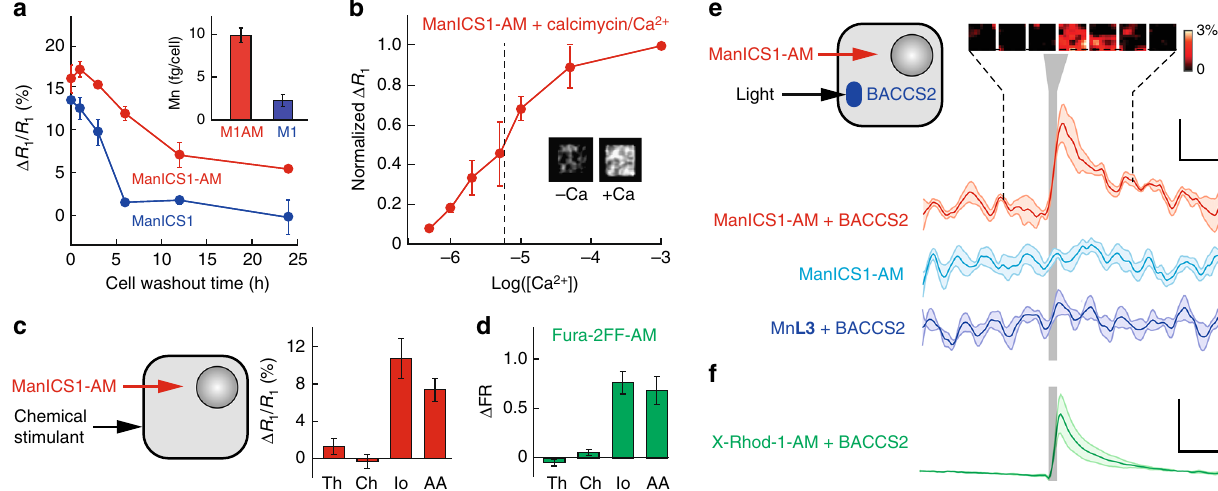
Fig. 4 ManICS1 reports calcium-dependent MRI signal changes in cells. a Washout time course of Δ R 1 / R 1 vs. time for HEK293 cells preincubated with 10 µ M ManICS1-AM (red) or ManICS1 acid form (blue). Elemental analysis of cytosolic fractions from incubated cell lysates (inset) indicates intracellular manganese accumulation in ManICS1-AM (M1AM)-treated cells but not ManICS1 (M1)-treated cells. b Titration of extracellular calcium concentration equilibrated in the presence of 10 µ M of the Ca 2 + ionophore calcimycin in ManICS1-AM-loaded cells. A midpoint of calcium-induced changes occurs at [Ca 2 + ] = 5 µ M. Inset compares MRI scans of cell pellets imaged in the absence (left) vs. presence (right) of 1 mM calcium. c Calcium responses measured from HEK293 cells labeled with ManICS1-AM and treated by extracellular addition of chemical stimulants (left). Signi fi cant R 1 changes are observed in response to ionomycin (Io) and arachidonic acid (AA) ( p ≤ 0.001), but not thapsigargin (Th) or carbachol (Ch) ( p ≥ 0.2). d Responses measured by fl uorescence spectroscopy from cells loaded with the fl uorescent calcium indicator Fura-2FF-AM under stimulation conditions as in c . e Cells were loaded by incubation with 40 µ M ManICS1-AM, transfected with the light sensitive Orai calcium channel activator BACCS2, and stimulated with 480 nm light (diagram at left). The red time course shows resulting changes in T 1 -weighted signal as a function of time, before, during, and after stimulation (vertical gray bar). Inset at top depicts image snapshots binned over successive 240 s windows during the time series portion indicated by dashed lines and indicating percent signal changes observed at a voxel level. Stimulus-dependent signal changes were not observed in analogous experiments performed using cells lacking BACCS2 (cyan) or cells labeled with Mn L3 instead of ManICS1-AM (blue). f Fluorescence time course observed from BACCS2- expressing cells incubated with 5 µ M X-Rhod-1-AM and stimulated as in panel e . Scale bars: horizontal = 300 s, vertical in e = 0.3%, f = 20%. Error bars represent SEMs of a three, b three, c six, and d six independent measurements. Shading in e and f represents SEM from fi ve